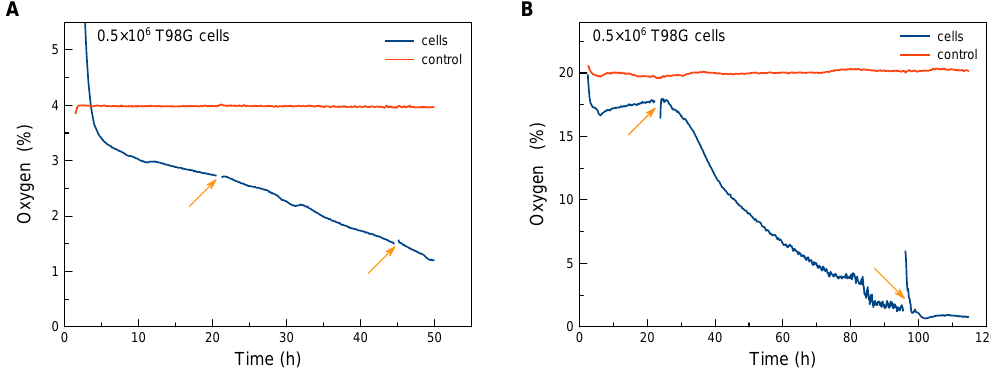
Figure 5. Monitoring of peri-cellular oxygen tension: The gas phase contained 4% O 2 to model hypoxia ( A ) and 20% O 2 ( B ). After several days of incubation the culture with high oxygen content in the gas phase also showed pericellular oxygen levels which are normally associated with hypoxia. The arrows indicate disconnection of the measurement and transfer of the flask to a microscopy stage for optical inspection of the cells. The control curve was measured in a SCCF without cells, which was kept in the respective incubation